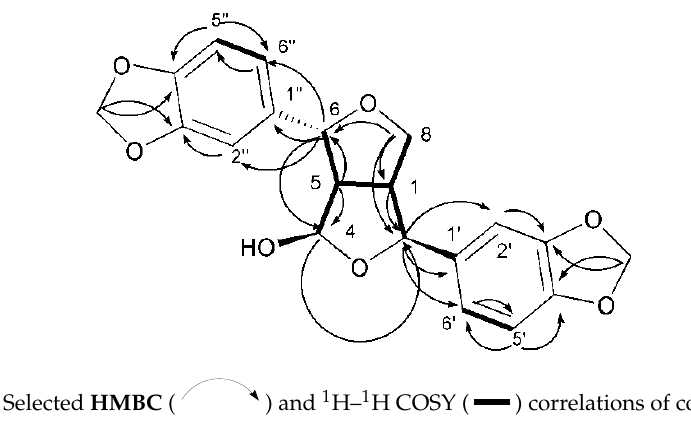
Figure 3. Selected HMBC ( ) and 1 H– 1 H COSY ( ) correlations of compound 35 .